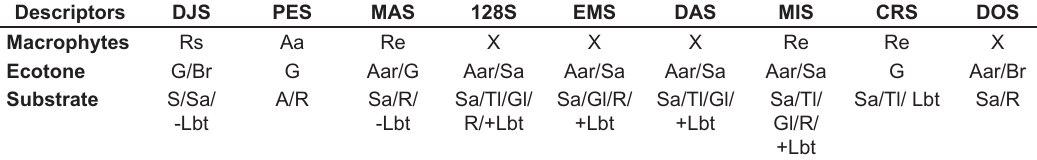
Table 2. Physiographic descriptors of each stream in the Machado River basin, July 2013 to May